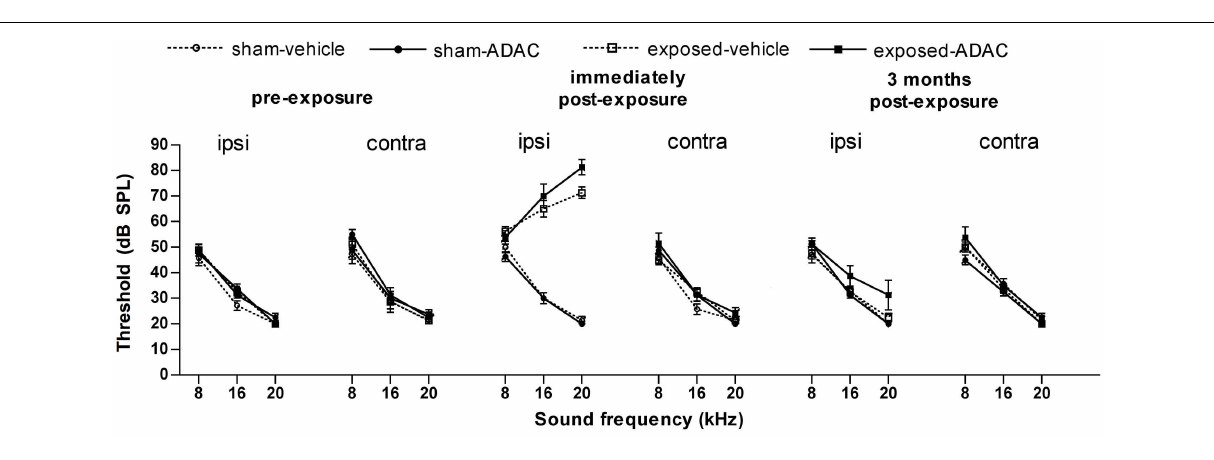
FIGURE 2 |Auditory brainstem-evoked response thresholds from another, similar experiment, in which measurements were made over 3months following the acoustic trauma. Data are shown for the ipsilateral and contralateral ears of acoustic trauma-exposed and sham